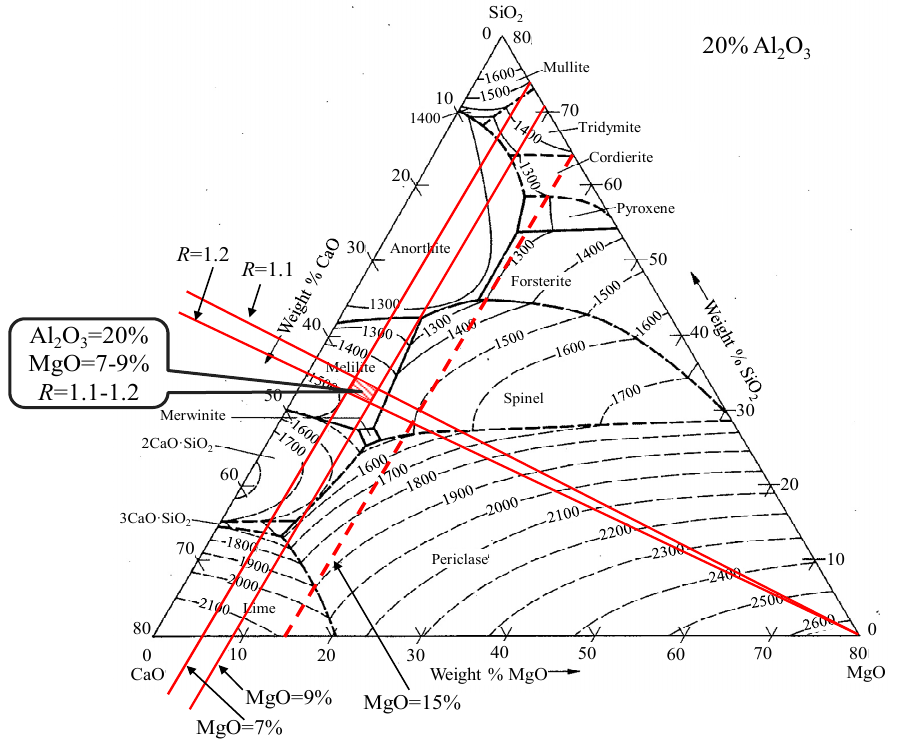
Figure 4. Phase diagram of CaO–SiO 2 –Al 2 O 3 –MgO quaternary slag system (Al 2 O 3 = 20%) [1].